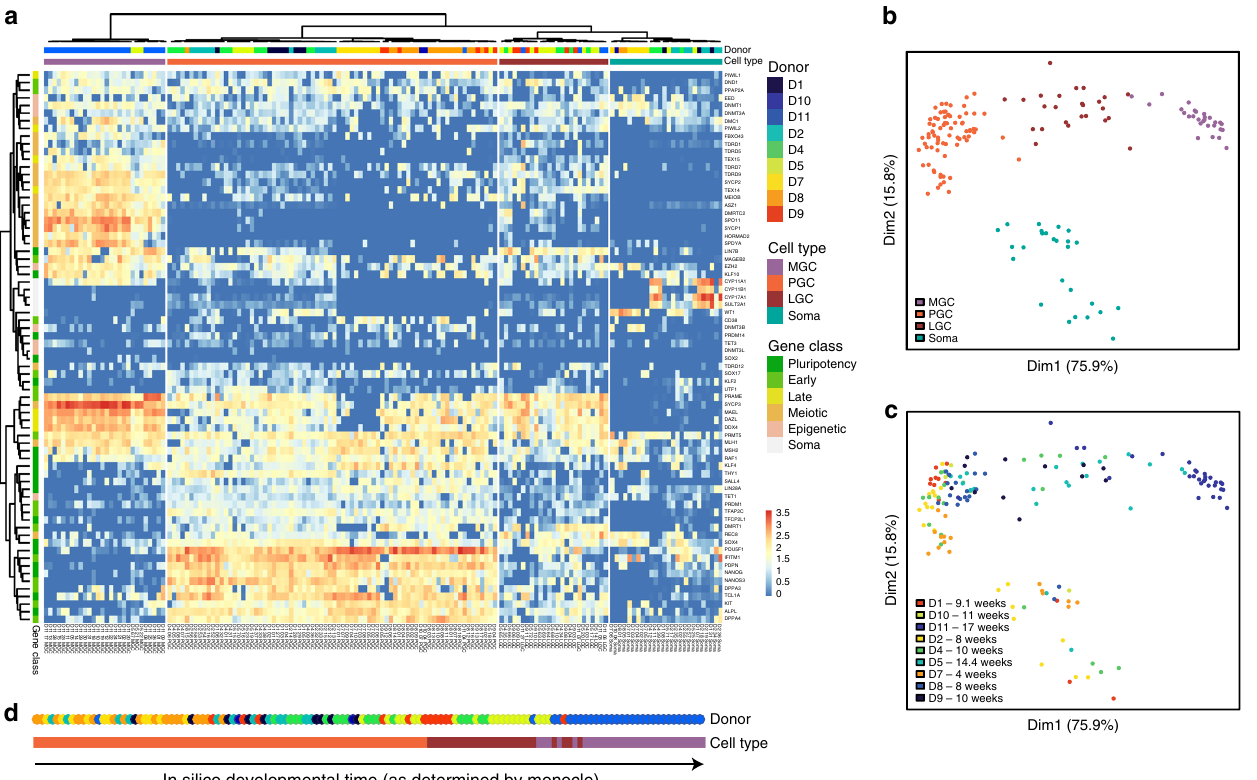
Fig. 2 Fetal age does not determine developmental stage of human germ cells. a Unsupervised hierarchical clustering of single female human germ cells, and the associated gene expression heatmap of germline-speci fi c genes, combining our dataset with female cells from Guo et al., 2015 yielded a total of 129 female germ cells and 26 female somatic cells from 9 different donors (D). The germ cells segregated into categories representing 3 different developmental stages, instead of segregating by donor or fetal age. The categories represent the transcriptional signatures of primordial germ cells (PGC), late germ cells (LGC) and meiotic germ cells (MGC). b , c Multidimensional scaling plots showing the individual somatic cells and germ cells (our dataset combined with that of Guo et al., 2015) color-coded by developmental stage (PGC, LGC, MGC) ( b ) and by donors of different fetal age (weeks) ( c ). d Individual germ cells (our dataset combined with that of Guo et al., 2015) ranked by their respective gene expression pro fi les using Monocle. This ranking is largely consistent with the independently identi fi ed developmental stages. Cells are colored according to the fetal age and developmental stage (PGC, LGC, MGC)